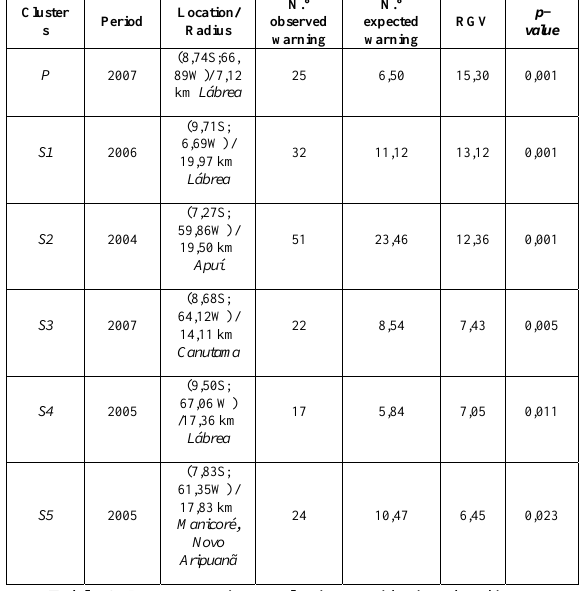
Table 2. Retrospective analysis considering the distance to roads (co-variable)